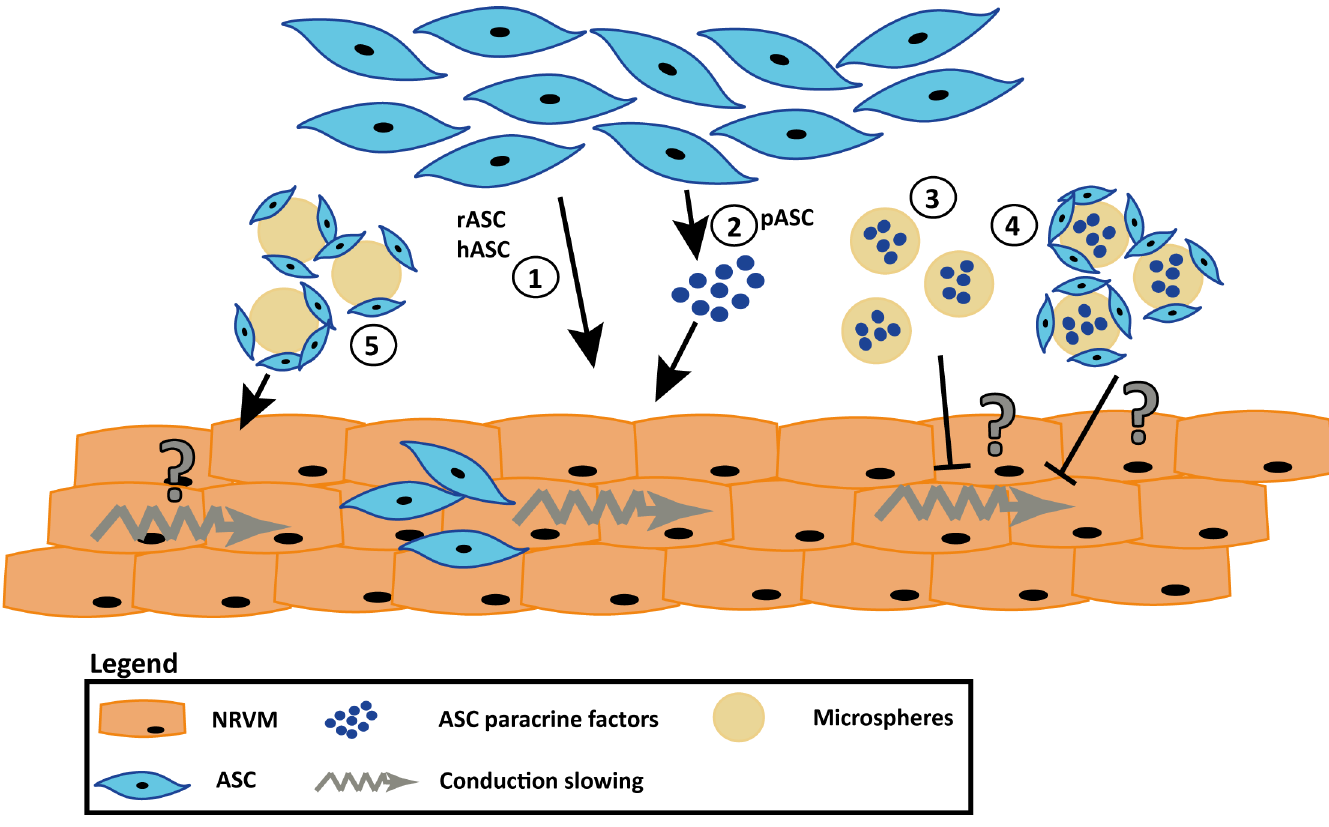
Fig 1. Schematic overview of the hypothesis that recombinant human collagen-based microspheres mitigate the conduction slowing induced by pASC. From previouswork we know that rASC and hASC induceconductionslowingthrough direct-electrotonic-coupling ( 1 ) and that pASC paracrine factors alone can induceconductionslowingin NRVM monolayers ( 2 ). We hypothesize that the microspheres will buffer the pASC paracrinefactors, and mitigate the conductionslowing( 3 ). The mitigating effect can also be achievedwhen the pASC are loadedonto the microspheres ( 4 ). When rASC or hASC are loadedonto the microspheres conductionslowingwill still occur as these cells induceconductionslowingthrough direct-electrotonic-coupling( 5 ). Abbreviations: hASC: humanadiposetissue-derived stromal cells, NRVM; neonatalrat ventricular myocytes, pASC: porcineadiposetissue-derived stromal cells, and rASC: rat adiposetissue-derived stromal